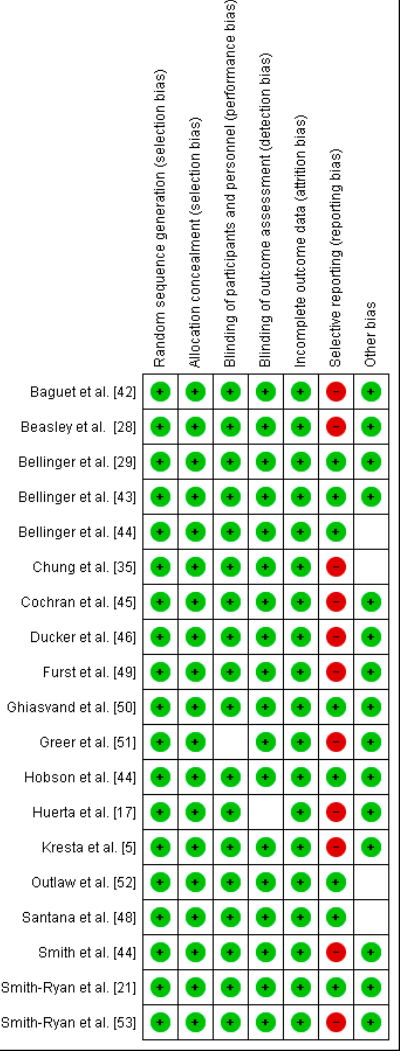
Figure 3. Risk of bias summary: review authors’ judgements about each risk of bias item for each included study.